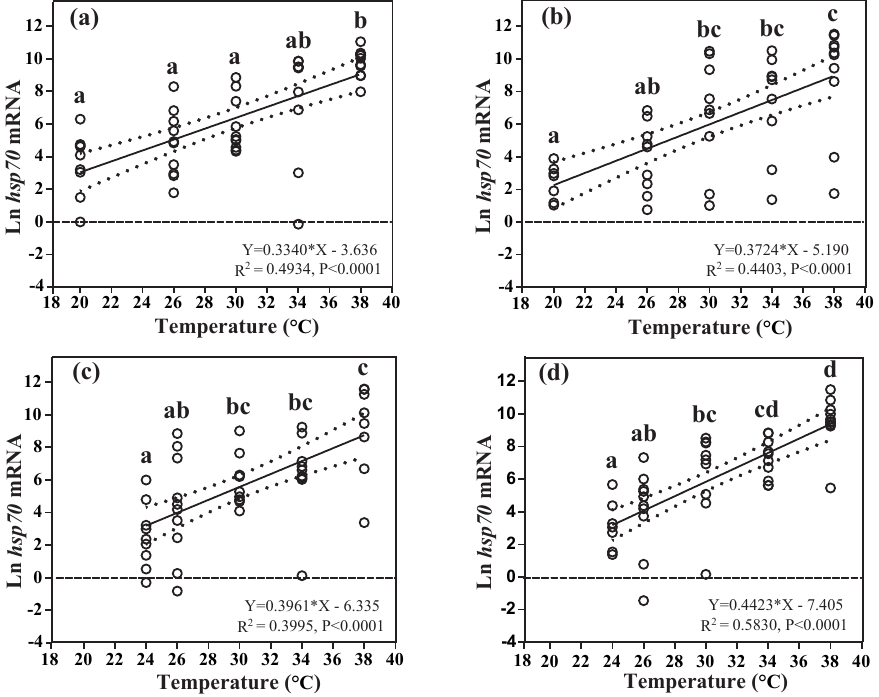
Figure 3. Effects of heat-shock temperature on the expression of hsp70 mRNA in limpets acclimated at (a) 20 ◦ C and 400ppm, (b) 20 ◦ C and 1000ppm, (c) 24 ◦ C and 400ppm, and (d) 24 ◦ C and 1000ppm. The relationship between heat-shock temperature and log-transformed gene expression of hsp70 was fitted using linear regressions with 95% confidence intervals (dashed lines). Different letters represent significant differences in the level of hsp70 mRNA among different heat-shock